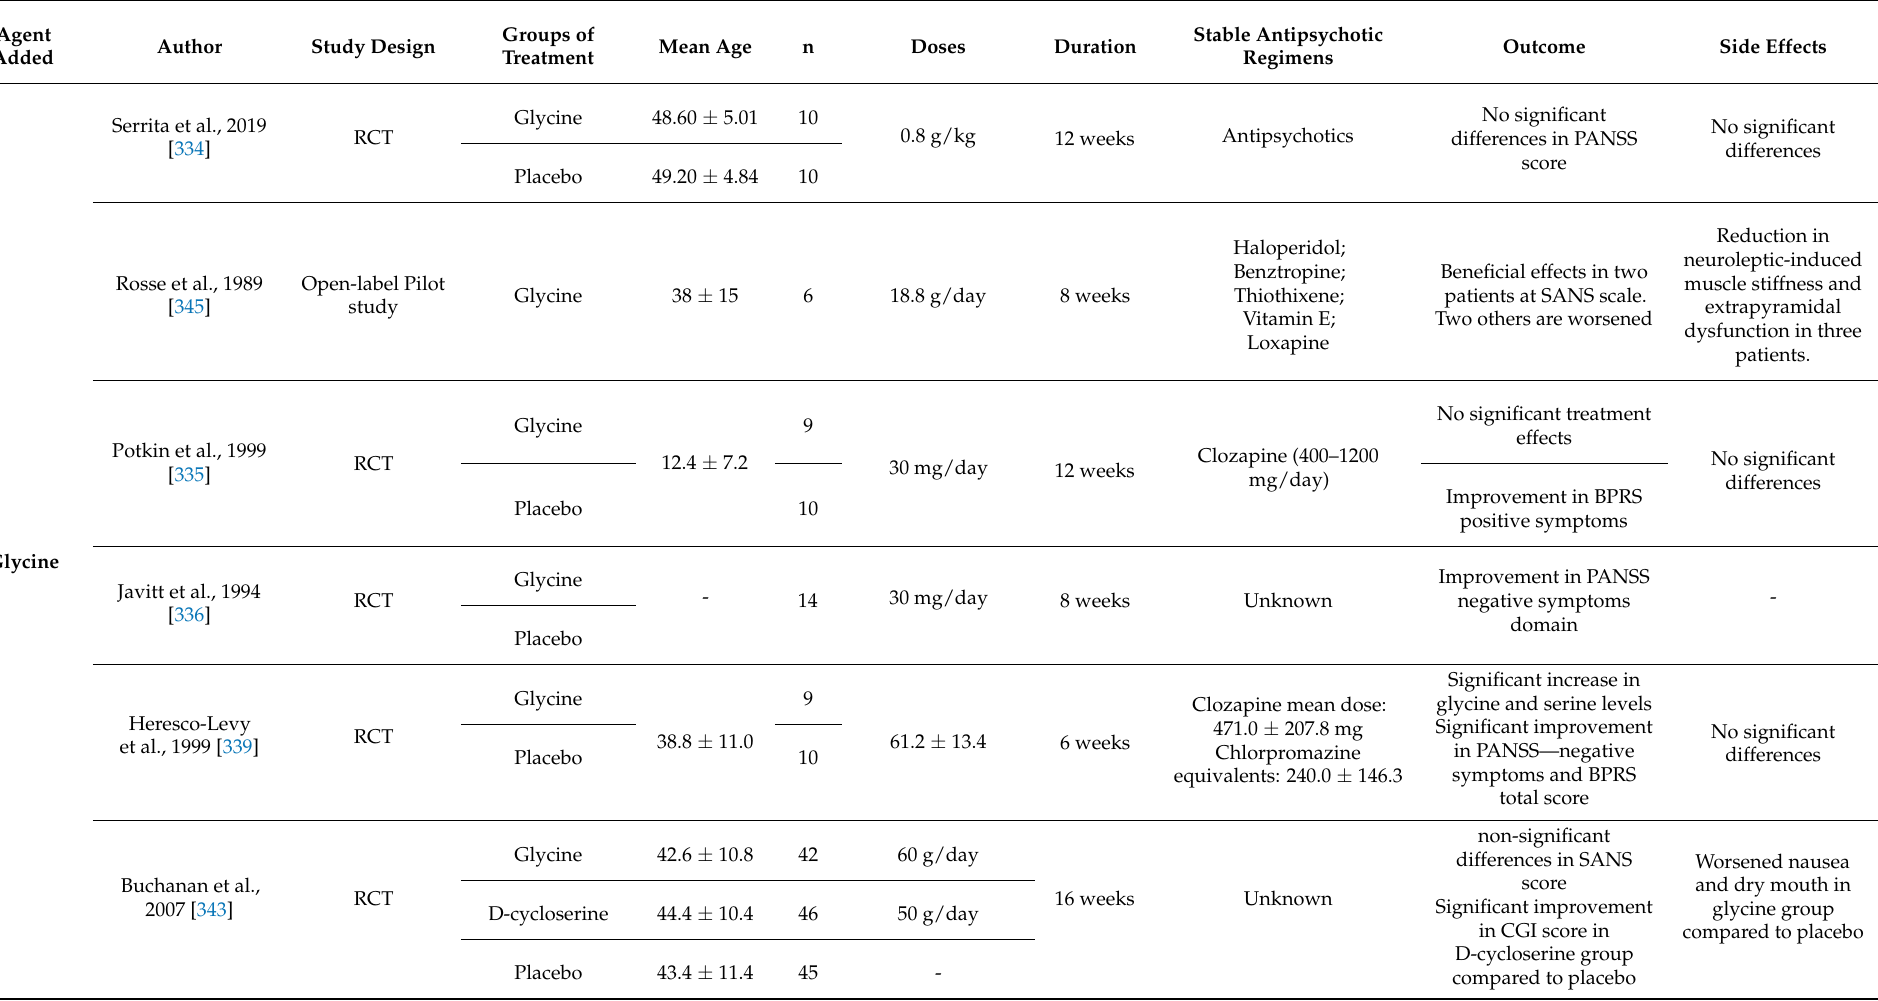
Table 3. Randomized clinical trials investigating the efficacy of glycine-centered agents in treating